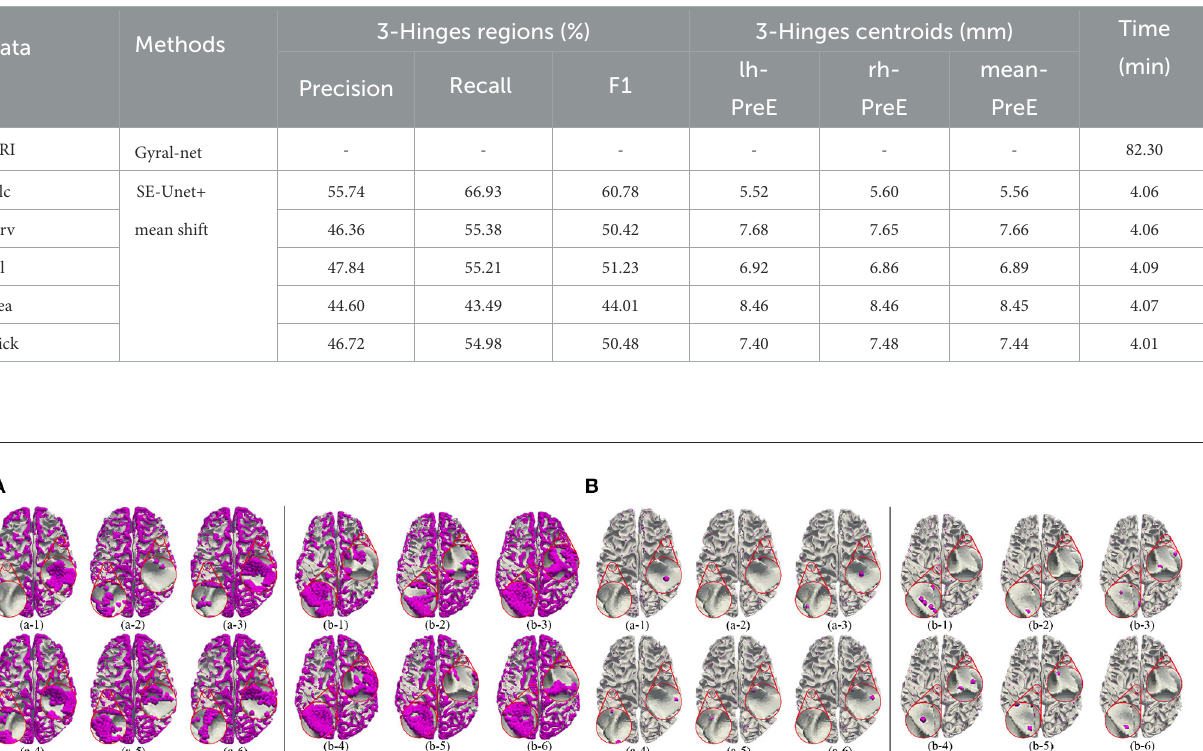
TABLE 2 The identification results on different single features.